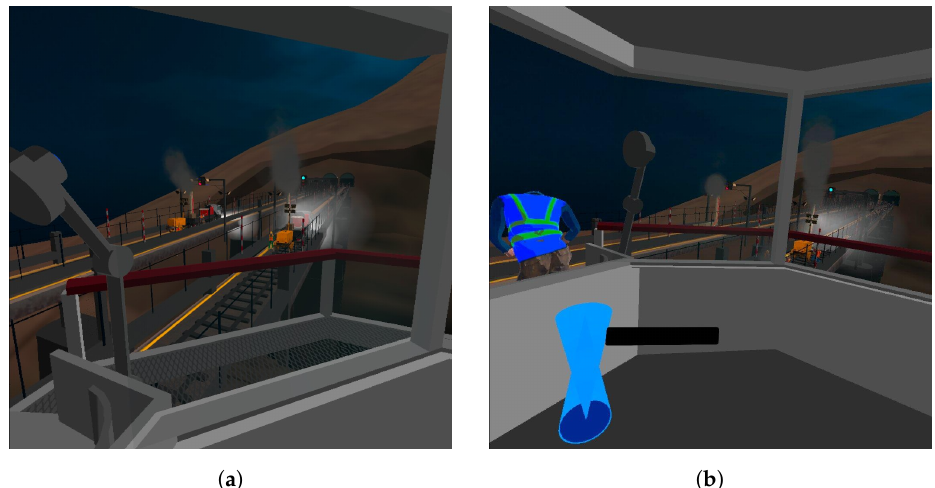
Figure 3. Moral Dilemmas. ( a ) In the Switch Dilemma, there are five workers on the main track and one worker on the spur track. Doing nothing results in the death of five workers, and using the switch system results in the death of one worker. ( b ) In the Push Dilemma, there are five workers on the spur track and the switch system is inoperable. Doing nothing results in the death of five workers, and pushing the worker from the control tower results in the death of that worker